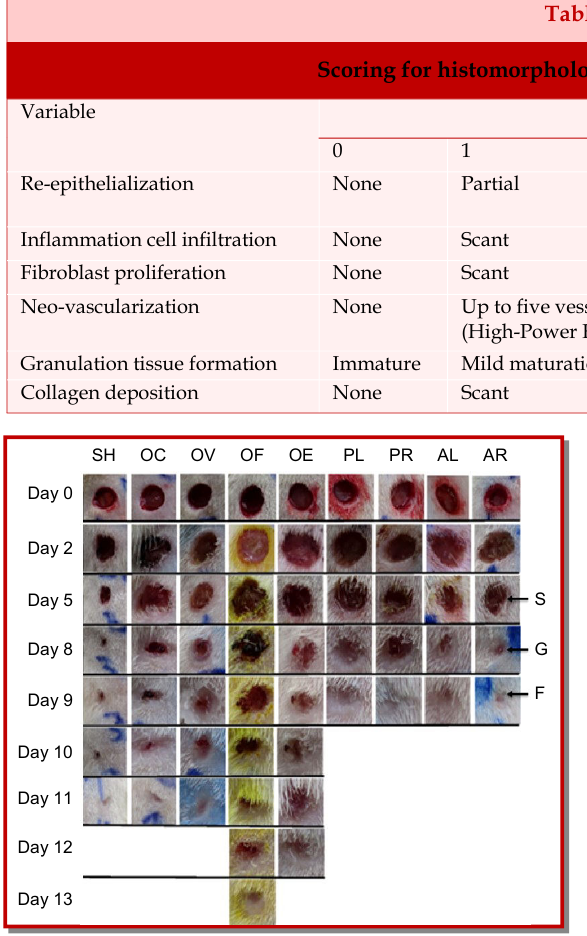
Figure 1: Macroscopic view of wounds of nine ovariectomized female rat experimental groups: SH, OC, OV, OF, OE, PL, PR, AL and AR against treatment day 0, 2, 5, 8, 9, 10, 11, 12 and 13. S = Scab, G = Granulation tissue and F = Fibrous tissue